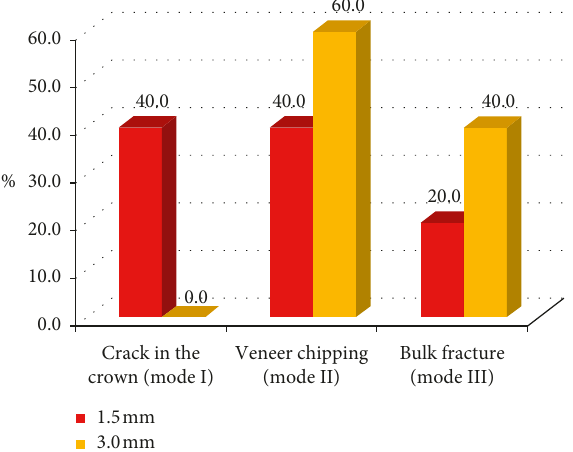
Figure 18: Bar chart showing the mode of fracture of each ve- neering thickness in both groups.